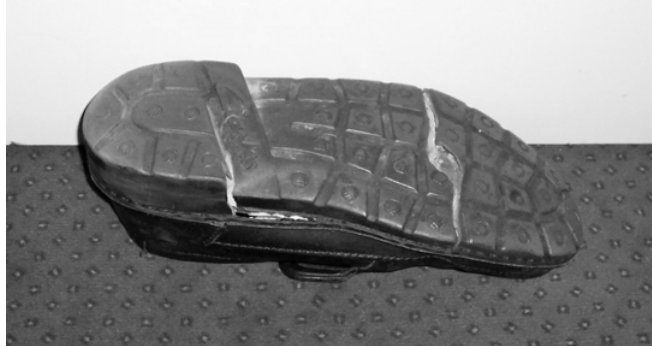
Figure 18. Cracks in sole of walking